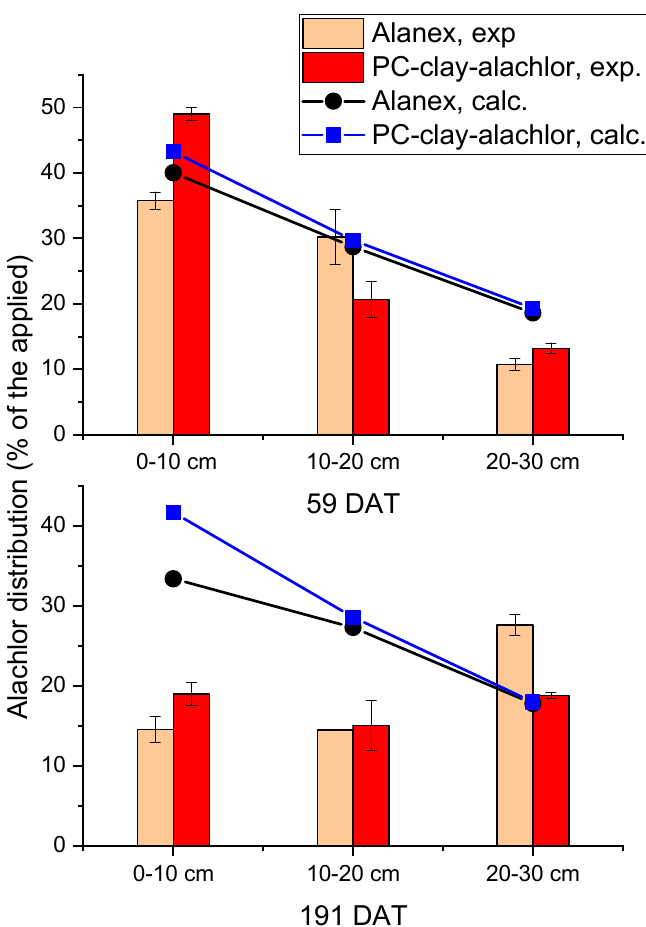
Figure 4. Distribution of alachlor applied as a commercial formulation (Alanex, 48% ai EC) and as a PC-clay formulation (40% ai) in soil depth 59 and 191 DAT. (Adapted from [60].). ( c ) Clay-ET15 Formulations of Mesotrione A micelle-clay formulation of the herbicide mesotrione with a content of 15% ai w:w was also tested against the commercial formulation Callisto (10% w:v ). The clay-based for- mulation was made of the fatty amine ethoxylated surfactant Ethomeen T15 (ET15). The formulations were used as post-emergence in a maize crop with sunflower as a model of broadleaf weed between maize rows. As previously, the herbicide was extracted from the soil at several depth levels 10 and 30 DAT. At the end of the experiment the crop yield was determined. The amount extracted at 10 DAT was about 7-fold higher for the micelle-clay-ET15 formulation relative to the commercial one in the upper layer, and about three-fold in the following layer (Figure 5). At the lowest depth, the amount of mesotrione was similar for both formulations. At 30 DAT, dissipation pattern is completely different. The residual amount in the upper layer is minimal for both formulations, and the amount determined at the largest depth was 4-fold higher for the commercial formulation. This behavior was explained by the fast-driven dissipation of this herbicide in soils via microbial degradation (its half-life in this soil was 10 d). Slow release was responsible for the large detection of the herbicide in the upper layers at 10 DAT. The microbial flora which is larger at these upper layers, degrades the herbicide that is slowly released and thus accessible. However, the herbicide migrated to the deepest layer is hardly degraded, increasing the risk for